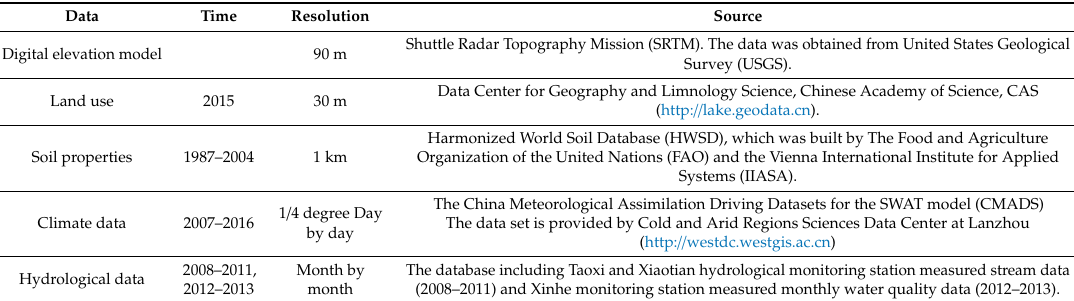
Table 1. Overview of data source of model